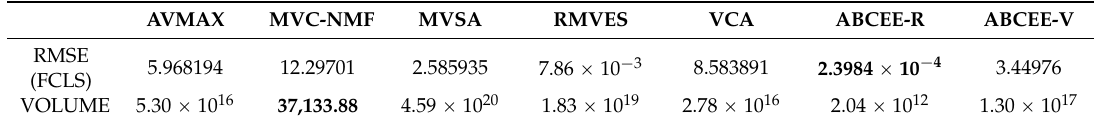
Table 5. Results for Cuprite